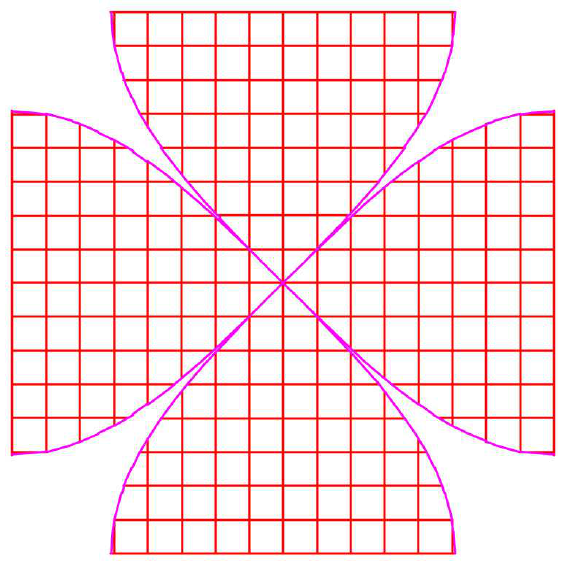
Figure 7. Development of a pavillon-vault.